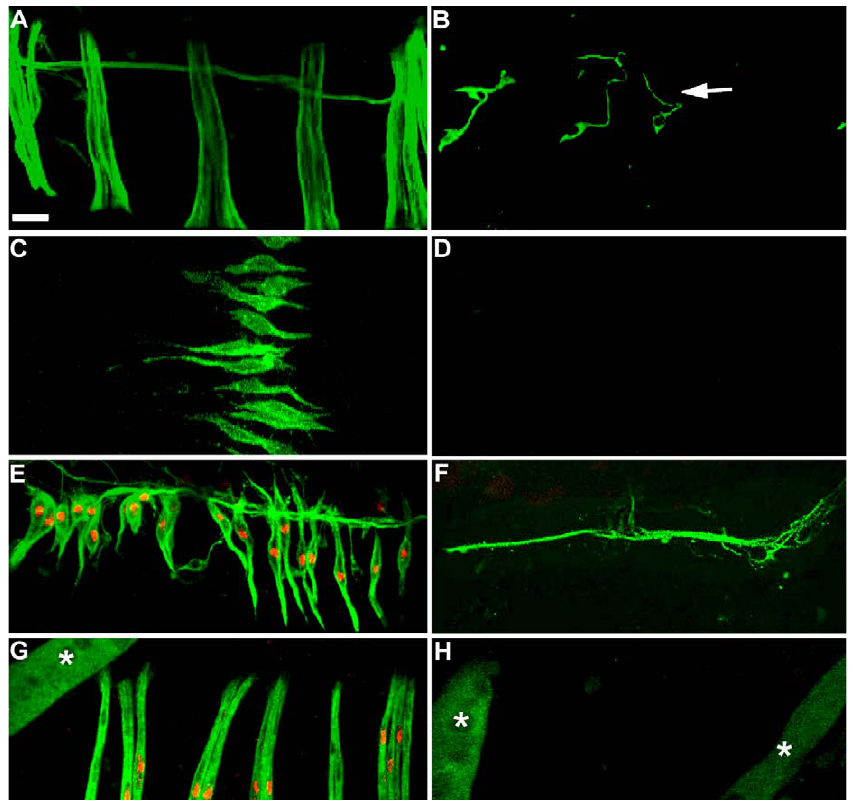
Figure 3. Founder-Pattern upon Decrease in Htl Signaling (A–D) Pupal preparations (grown at 29 8 C) stained with 22C10 to visualise the founders. (A) A Canton-S pupa 30 h APF showing a subset of dorsal founders. (B) A similarly aged pupa of the genotype 1151/ þ ; UAS-dnhtl/ þ ; UAS-dnhtl/ þ showing absence of dorsal founders. The white arrow points to a neuronal branching labelled by 22C10. (C) A preparation 28 h APF of Canton-S pupa showing lateral founders. (D) A 1151/ þ ; UAS-dnhtl/ þ ; UAS-dnhtl/ þ pupa, similarly aged as in (C), showing no founders in the lateral hemi-segment. (E and F) A preparation 28 h APF (grown at 29 8 C) of a duf-lacZ pupa (E) and a 1151/duf-lacZ; UAS-Yan act / þ pupa (F) double-labelled with anti- b - galactosidase (red) and 22C10 (green). (E) shows wild-type pattern of a subset of dorsal founders. (F) shows complete absence of founder cells. Only the nerve, stained by 22C10, is visible. (G and H) A preparation 42 h APF (grown at 29 8 C) of a duf-lacZ pupa (G) and a 1151/duf-lacZ; UAS-Yan act / þ pupa (H) double-labelled with anti- b - galactosidase (red) and anti-MHC (green). In contrast to the wild-type pattern of dorsal muscles (G), no muscles are formed in the UAS-Yan act mis- expression pupa (H). The absence of muscles is not an experimental artefact because in the same preparation the unhistolysed larval muscles [66] can be viewed (white asterisks in [G] and [H]). Anterior is at top; dorsal midline is at left. Scale bar ¼ 20 l